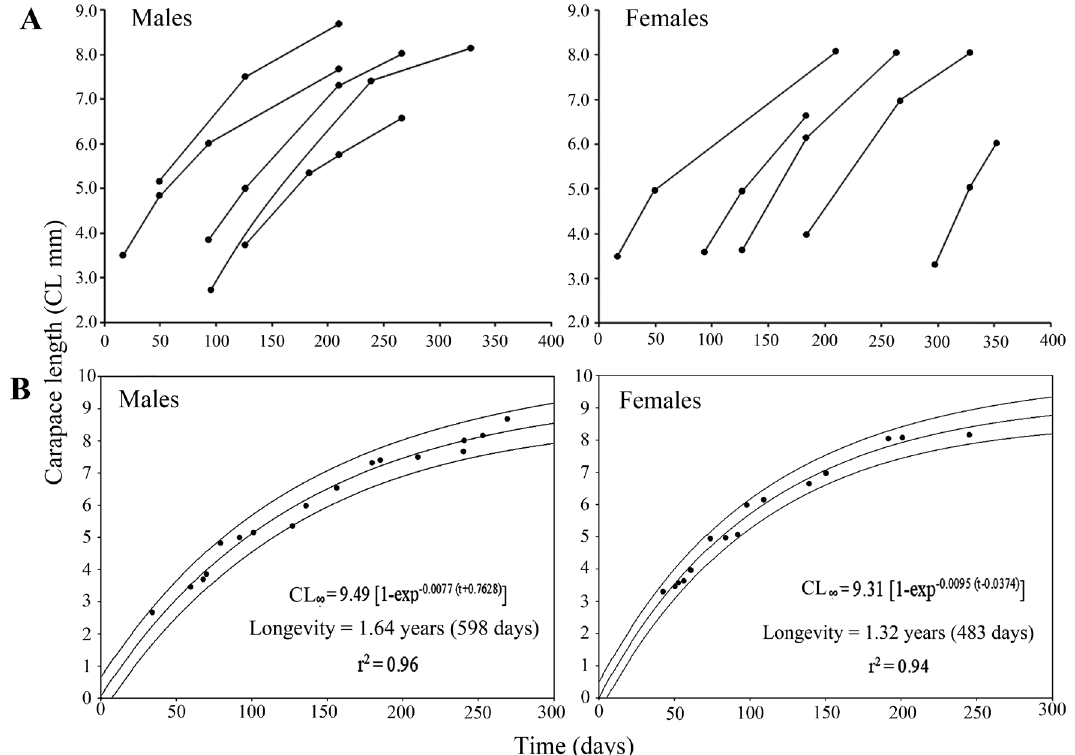
Figure 4. Alpheus brasileiro Anker, 2012. A, Cohorts identified during sampling describing the growth of each sex. B, Bertalanffy´s equation parameters estimated for males and females. The central line = mean; external lines = prediction intervals (95%).